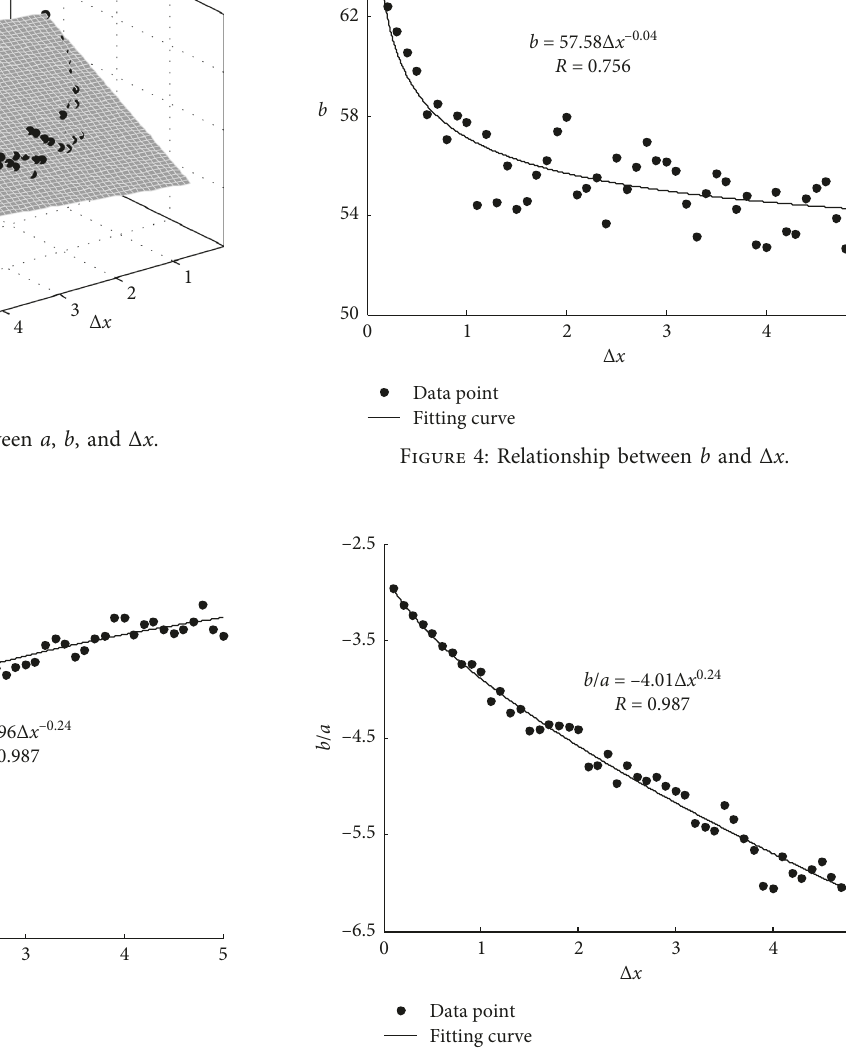
Figure 3: Relationship between a and Δ x